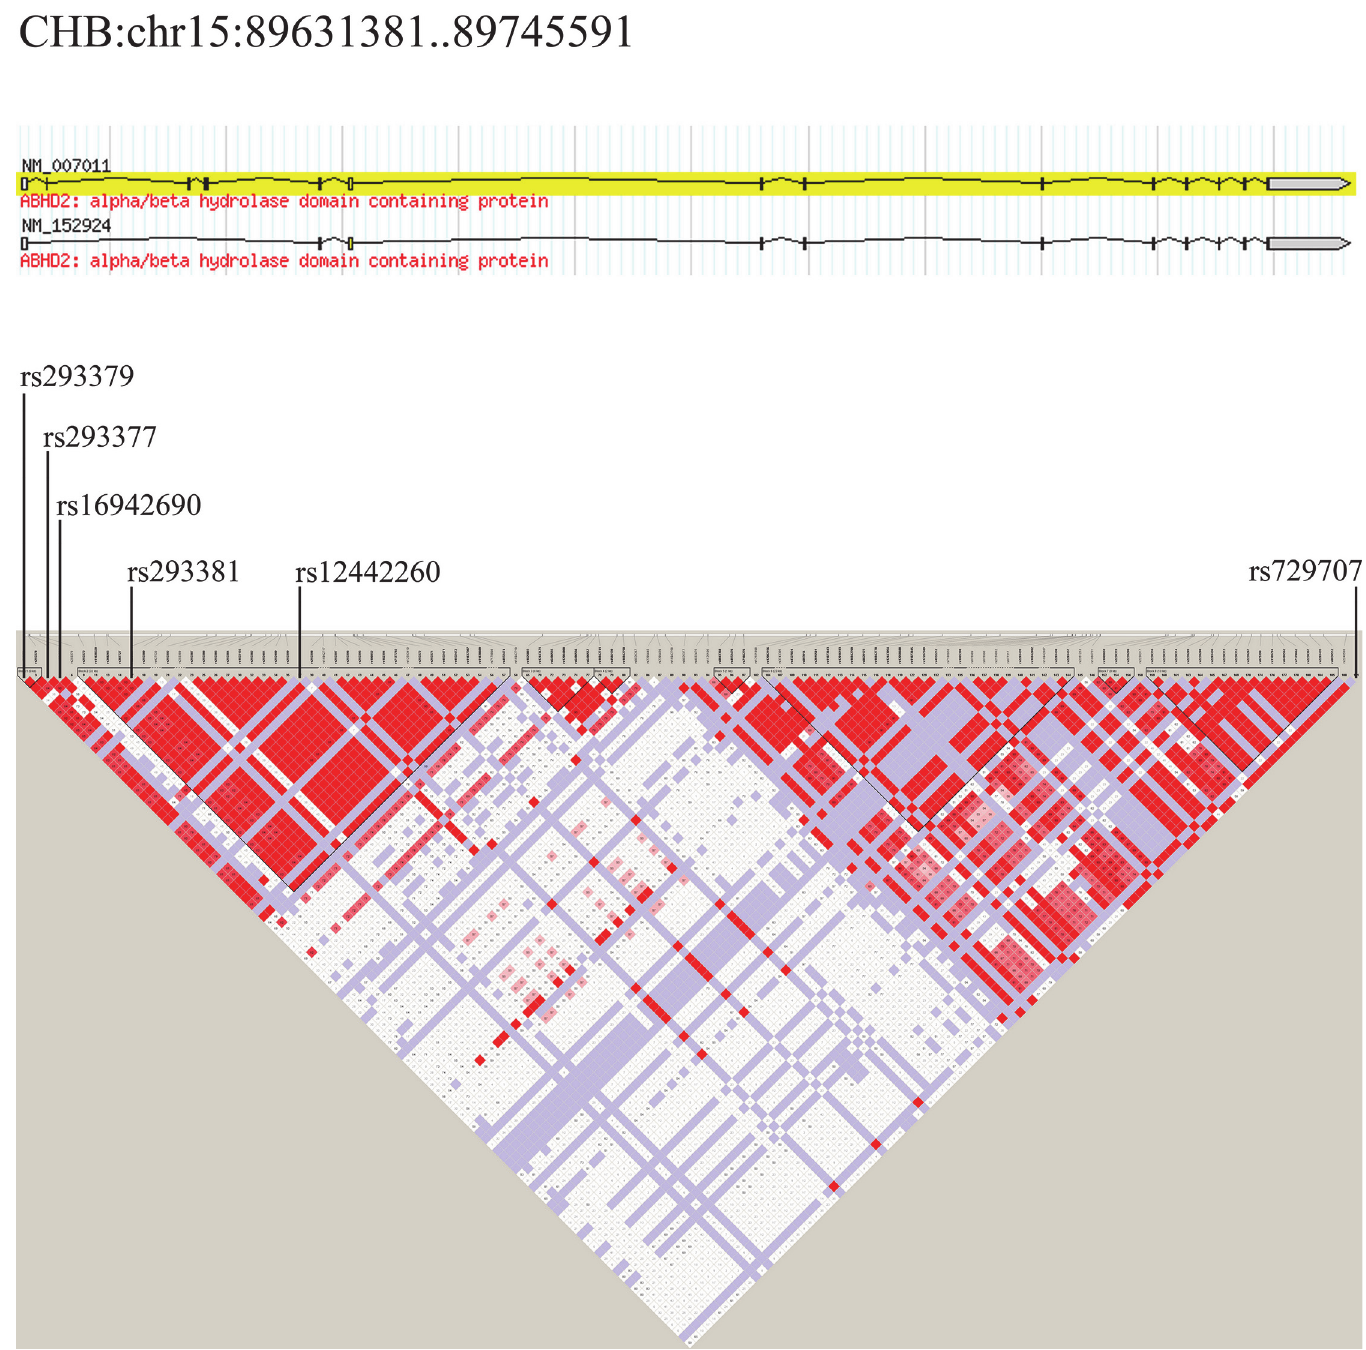
fragment lengths are listed in S3 Table. DNA samples were sequenced using a 3730 DNA Ana- lyzer (Applied Biosystems Inc., USA), as shown in S1 Fig.